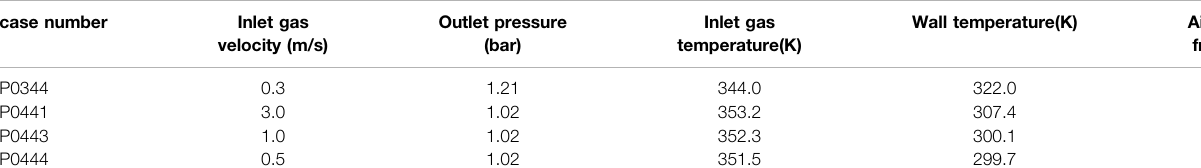
TABLE 1 | COPAIN experimental conditions.